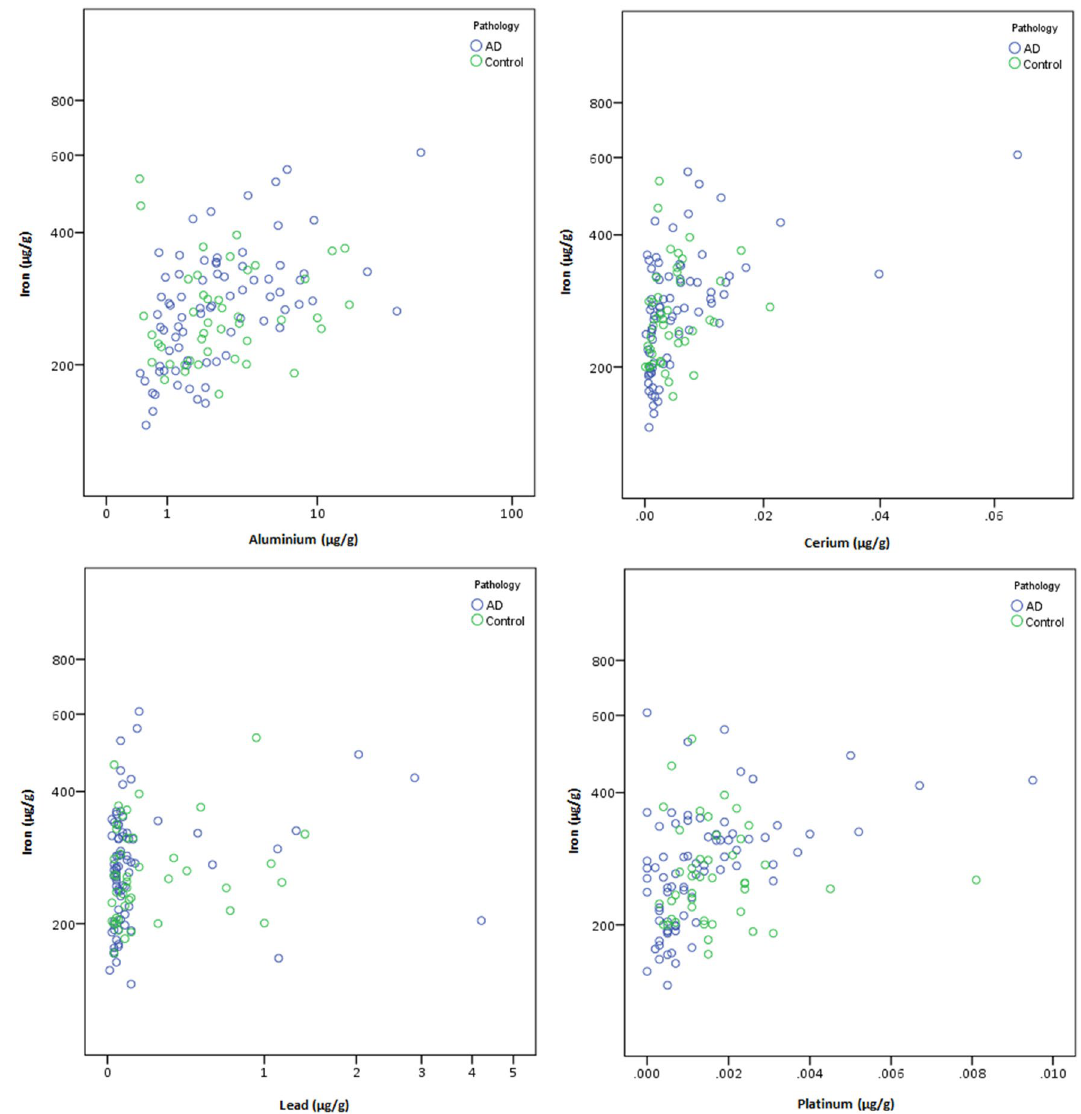
Figure 5. Mass-normalised concentrations of exogenous metals in human brain regions from AD and control brains from Manchester Brain Bank, UK. Scatter plots represent ICP-MS measurements of aluminium, cerium, iron, lead and platinum in freeze-dried human tissue from AD (n = 19) or control (n = 11) brains from the cerebellum, frontal lobe, occipital lobe, and temporal